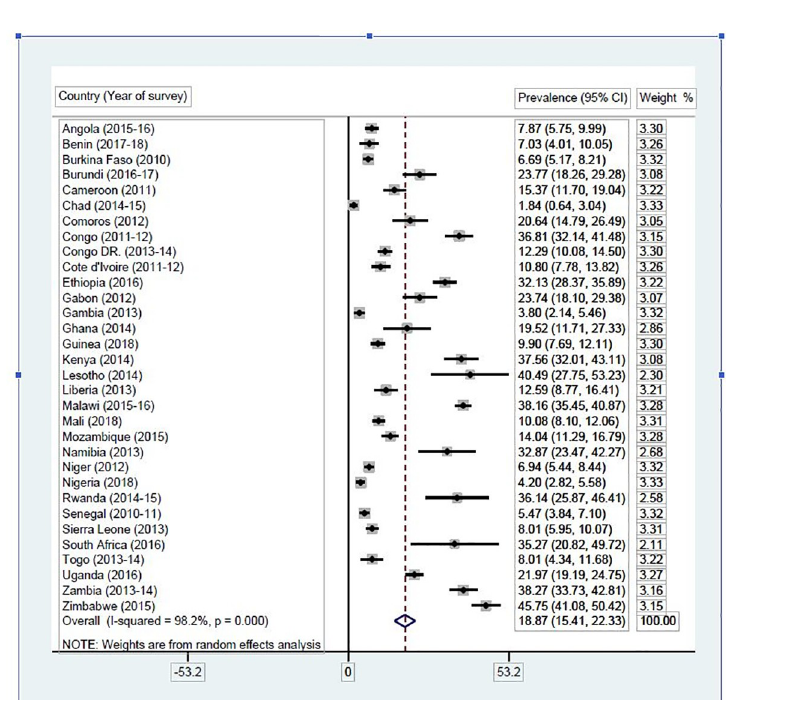
Fig 1. Contraceptive prevalence among female adolescents in SSA. Source: Authors’ computations.